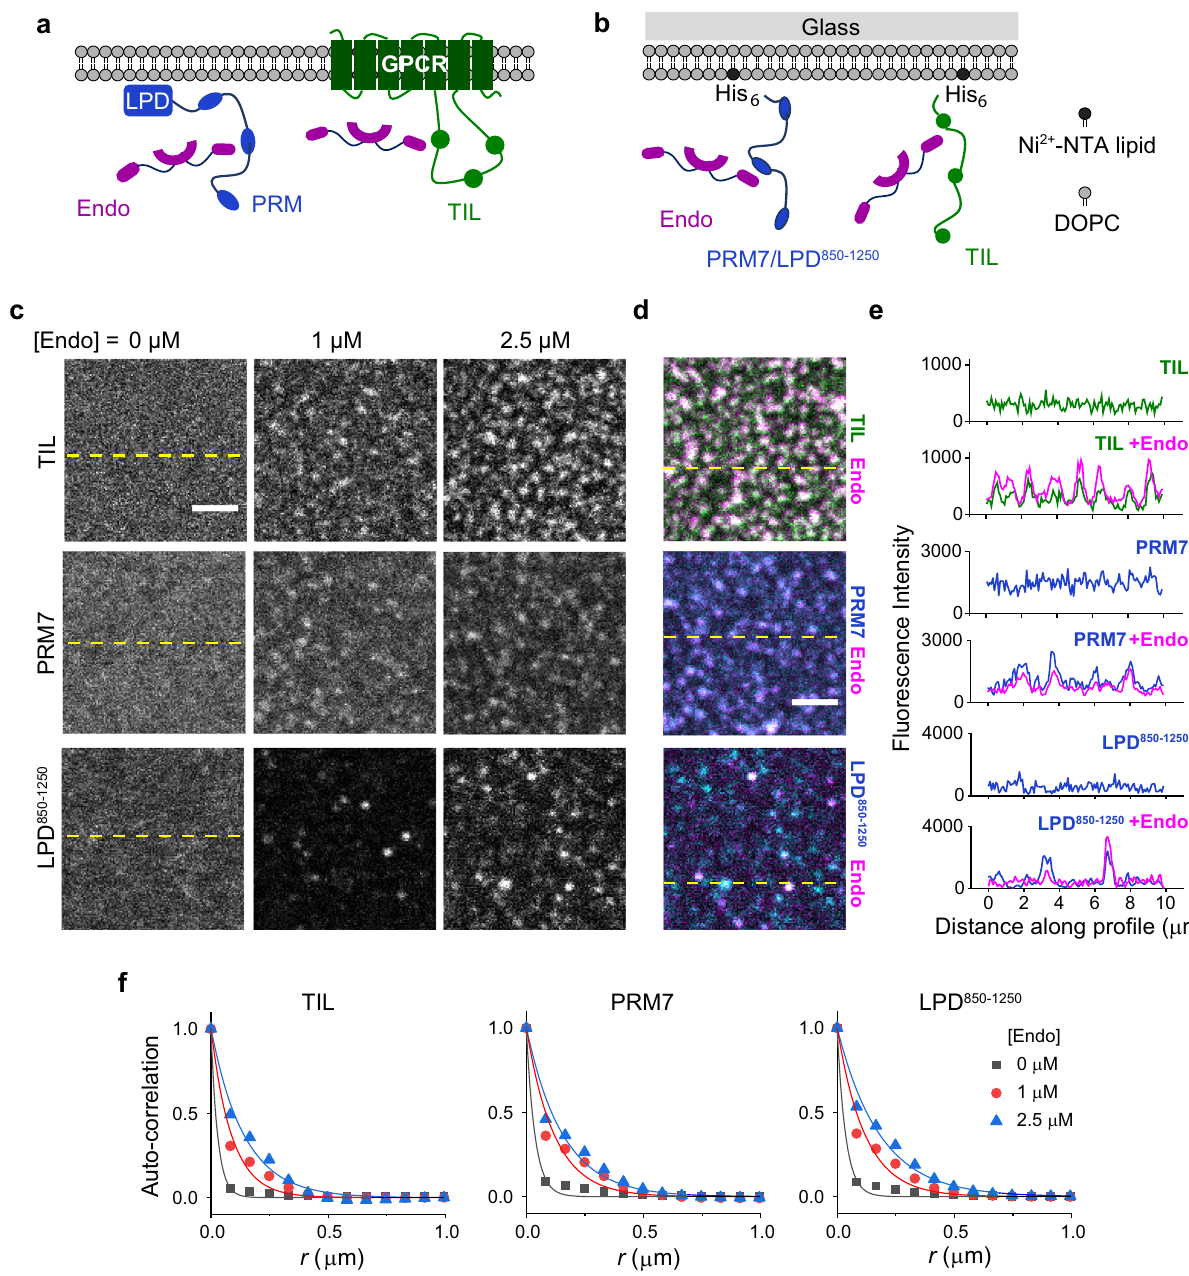
Fig. 4 | Endophilin forms clusters on the membrane in the presence of multi- valent binding partners. a Cartoon representation of the interactions between endophilinandproline-rich-motifsofGPCR-TILandLPDC-terminaldomainoncell membrane. b An in vitro model system that has been developed to mimic the endophilin – LPD – GPCR interactions using solid-supported bilayers (SSBs) with conjugated either PRM7-His 6 or LPD 850 – 1250 -His 6 and TIL-His 6 via Ni 2+ -NTA-lipids (right). c Confocal images showing distributions of TIL-Alexa 488 (top), PRM7- Alexa 633 (middle), and LPD 850 – 1250 -Alexa 647 (bottom) on SSBs composed of Ni 2+ - NTA lipid and DOPC (1:99). Images were recorded after incubating the functiona- lized SSBs with 0, 1, and 2.5 µ M endophilin for 30min. Scale bar 2.5 µ m. d Merged images of endophilin-Alexa 594 channel with TIL-Alexa 488 channel (top), PRM7- Alexa 633 channel (middle), and LPD 850 – 1250 -Alexa 647 channel (bottom) in the